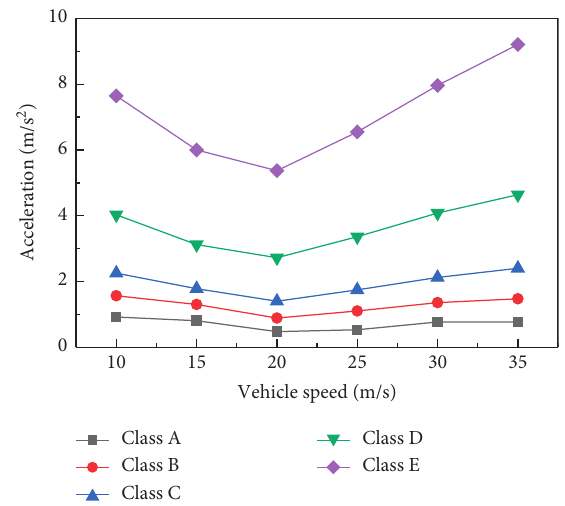
Figure 10: Maximum response of vehicle acceleration via various vehicle and roughness classes.